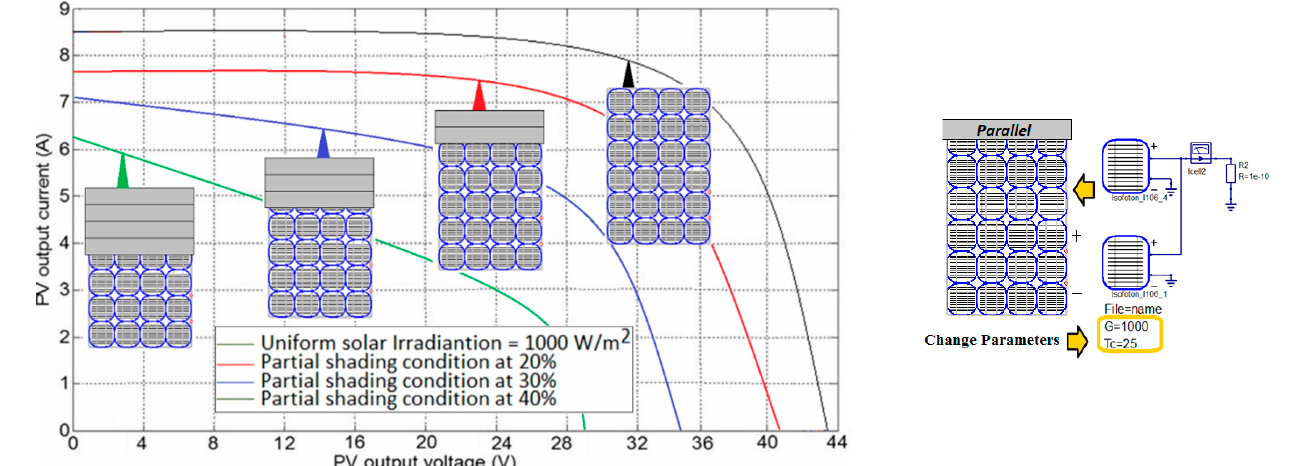
Figure 11. Current-Voltage characteristics under different partial shading conditions for parallel approach.